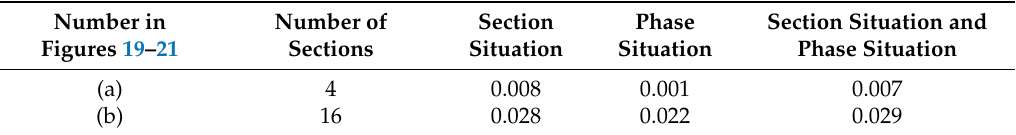
Table 18. Comparison of the variances of the